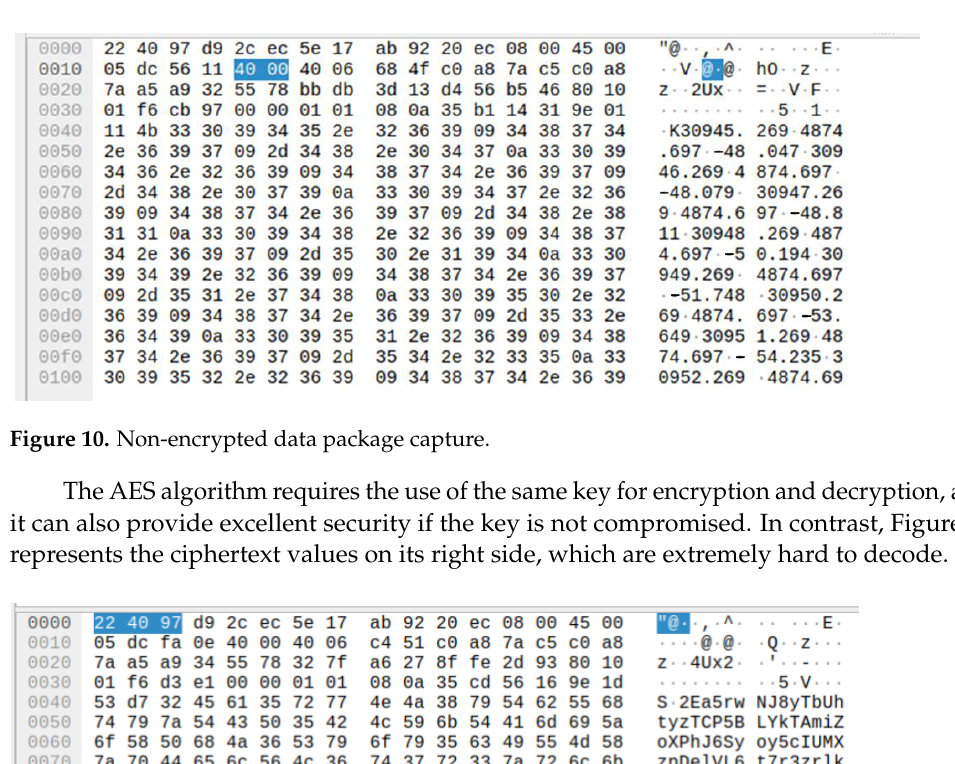
Figure 9. Encrypted file throughput.